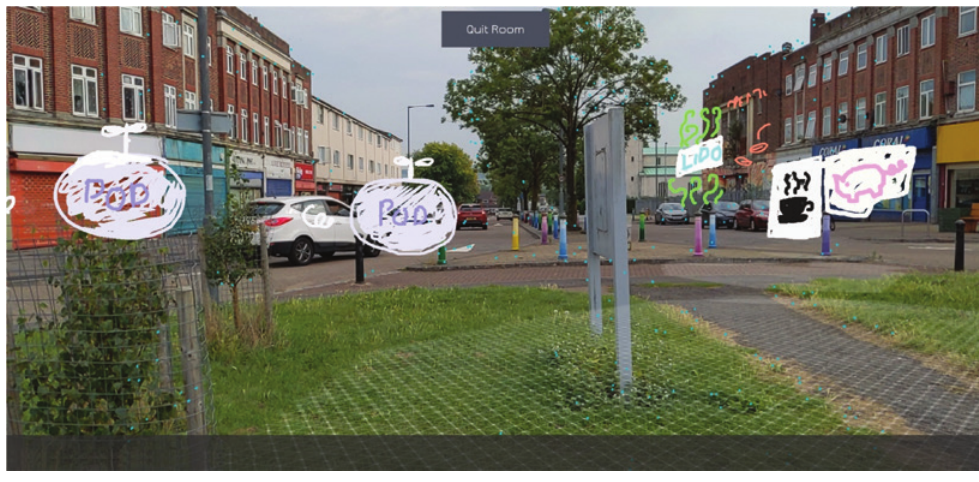
figure 9: aR drawings, filwood Broadway, august 2020 (screenshot: Michele Panegrossi; live aR illustration: